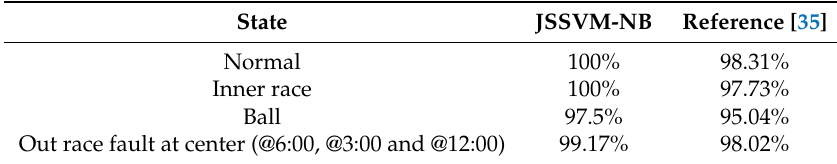
Table 8. The comparison results in bearing fault